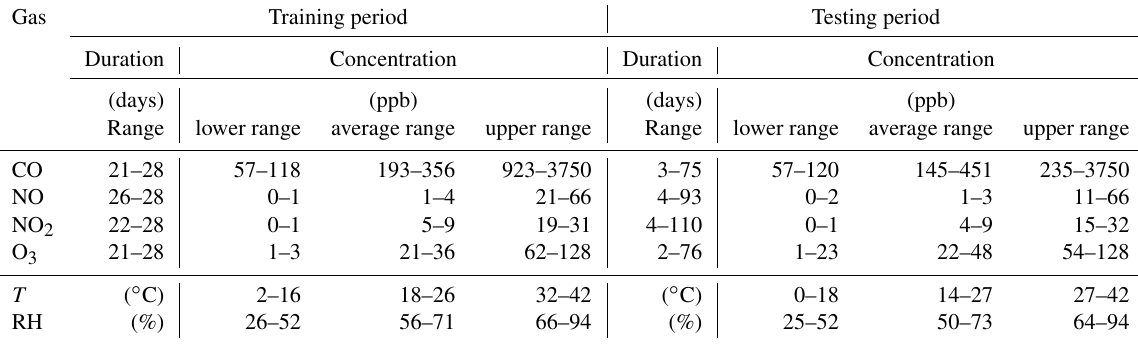
Table 4. Durations and ranges of testing and training data at CMU in 2017. Durations of the training and testing periods are in days. Ranges indicated are in parts per billion for all gases, degrees Celsius for temperature ( T ), and percent for relative humidity (RH). Note that because training and testing periods vary for different RAMPs, as described in Sect. 2.3, the duration and concentration ranges of the training and testing periods will likewise vary. This table gives an indication of the variability in training and testing period durations across RAMPs, as well as the variability in concentrations, temperature, and relative humidity. The “lower range” indicates the variability in the lowest 15min average concentration experienced by RAMPs during training or testing. Likewise, the “upper range” indicates the variability in the highest 15min average concentrations. The “average range” indicates the variability in the average 15min average concentration across RAMPs for either the training or testing period. Further information about these ranges is provided in the Supplement (see Figs. S11–S15).